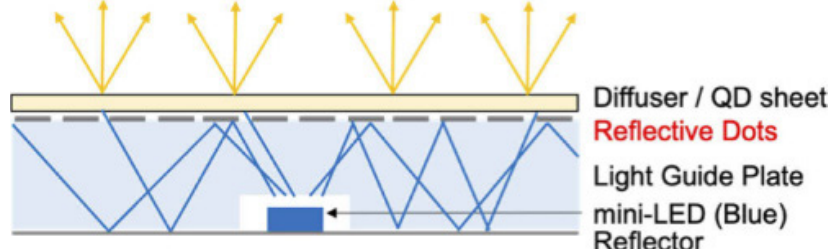
Figure 10. Proposed mini-LED backlight structure with reflective dots (one segment) [33].